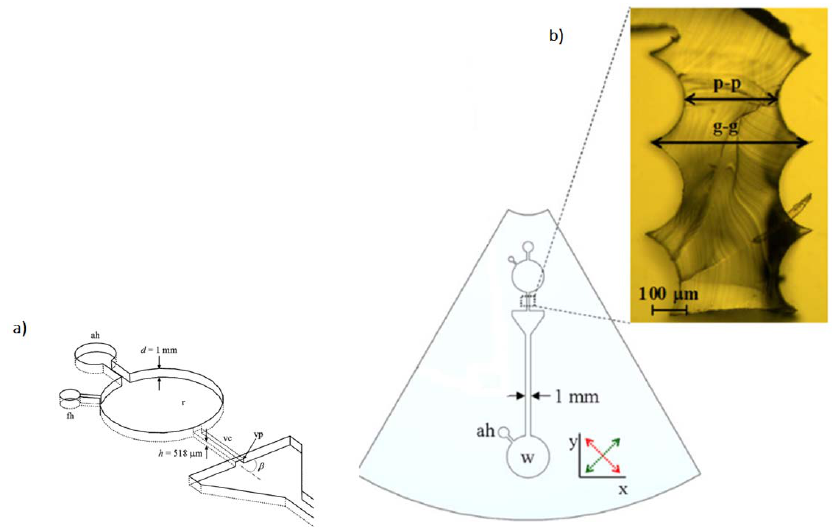
Figure 4. ( a ) Microfluidic architecture and tunnel structures. “ah” is air hole, “fh” is fill hole, “r” is the test fluid reservoir, “vc” is the valve channel, “vp” is the valve point or point of rapid channel expansion, “d” is the feature depth, and “h” is the valve channel height; ( b ) Microfluidic architecture showing a detail of the valve channel cast in PDMS (size 254 × 1016 μ m 2 ). “p ‐ p” is the measured peak ‐ to ‐ peak distance, and “g ‐ g” represents the groove ‐ to ‐ groove distance. (Reproduced with permission from [25].) Modular reactors with embedded functional features have also been demonstrated with FFF, in the so ‐ called millifluidics and reactionware devices that were the central focus of the work by Cronin and co ‐ workers [42].